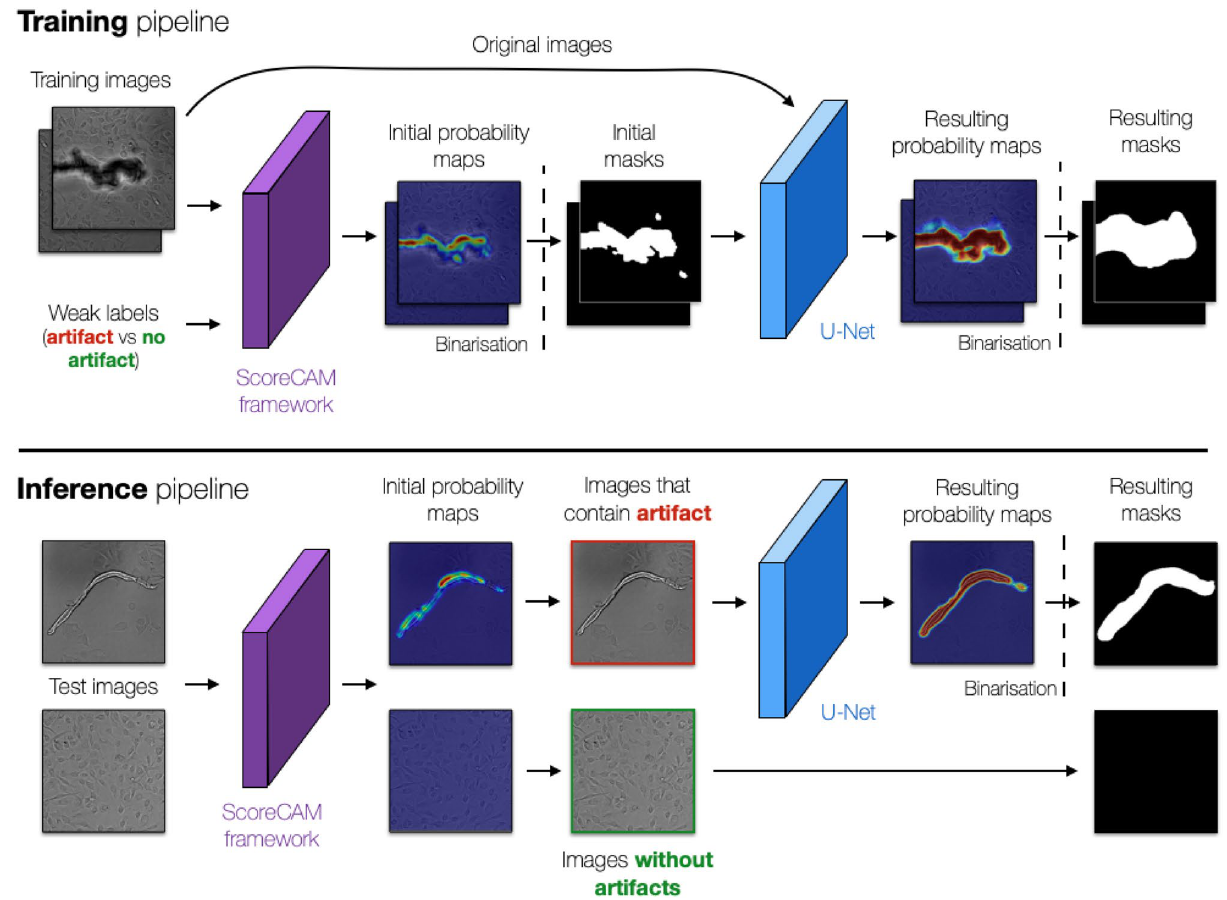
Figure 1. Artifact segmentation pipeline—ScoreCAM-U-Net. During training (top), ScoreCAM 18 (purple) is used to generate pixel-level probability maps of artifacts and the corresponding binary masks that are used to train the U-Net 4 segmentation model (blue). During the inference (bottom), the trained U-Net (blue) is used to segment artifacts from the images that were deemed to contain artifacts (image with red borders) by the ScoreCAM (purple). Vertical dashed lines: binarization of pixel probability maps